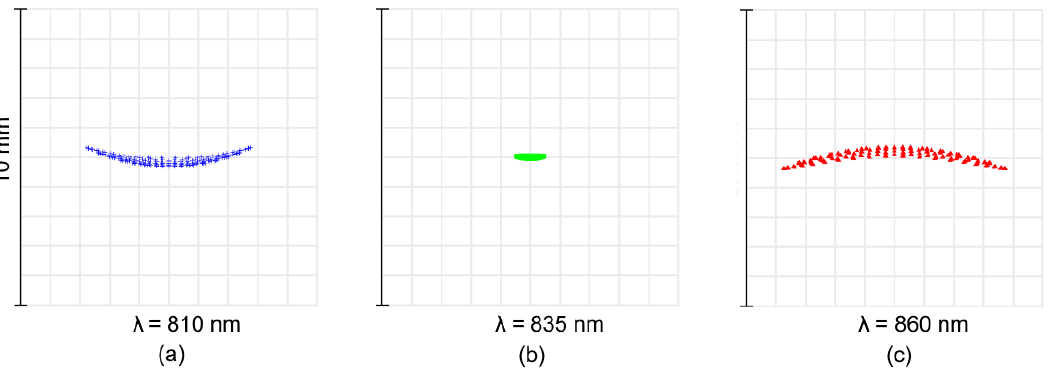
Figure 10. Spot diagrams of the high-dispersion spectrograph Design